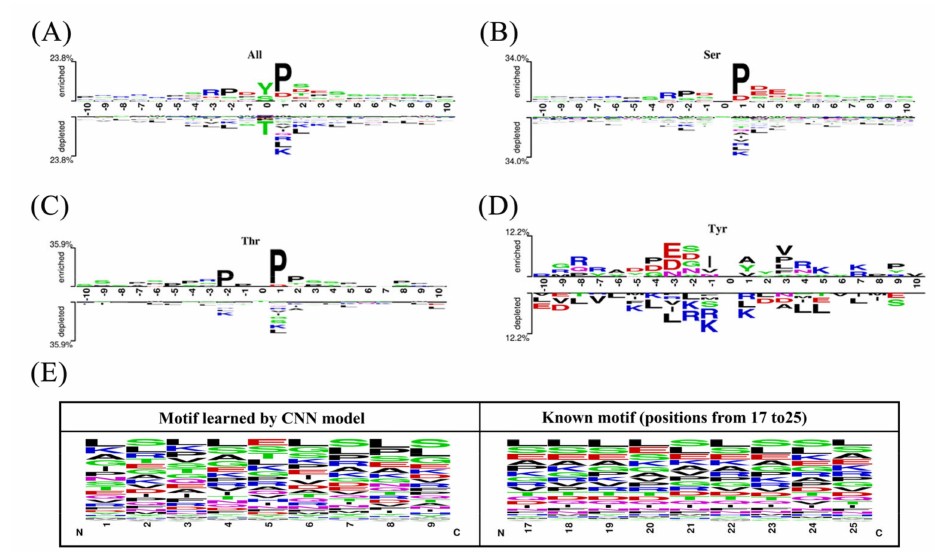
Figure 3. ( A – D ) The different position-specific distribution of amino acids between leukemia-related phosphorylation sites and non-phosphorylation sites segments for All, Ser, Thr and Tyr peptides, respectively. ( E ) The comparison between the motif learned by the deep CNN model and the known motif of leukemia-related phosphorylation